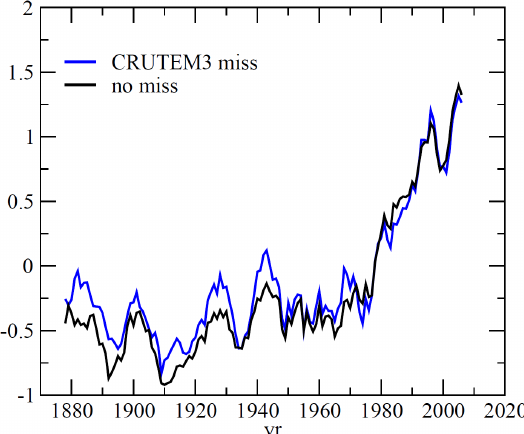
Fig. 2. Arctic cold season (November–April) SAT anomalies ( ◦ C) simulated in the HadISST ensemble mean with (blue) and without (black) data sampling according to CRUTEM3 data.